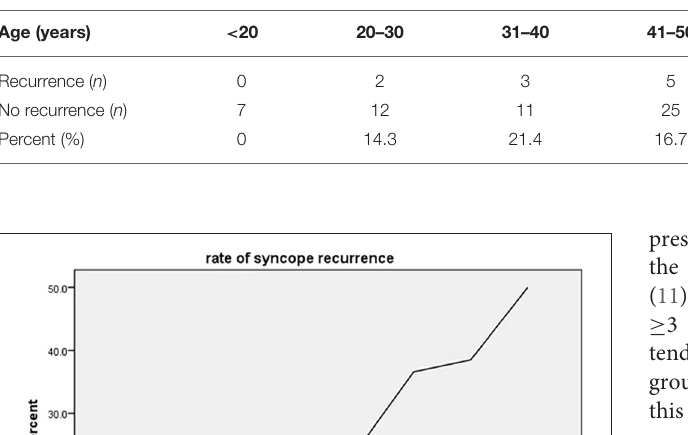
TABLE 3 | Sample sizes for all ages in the study population.